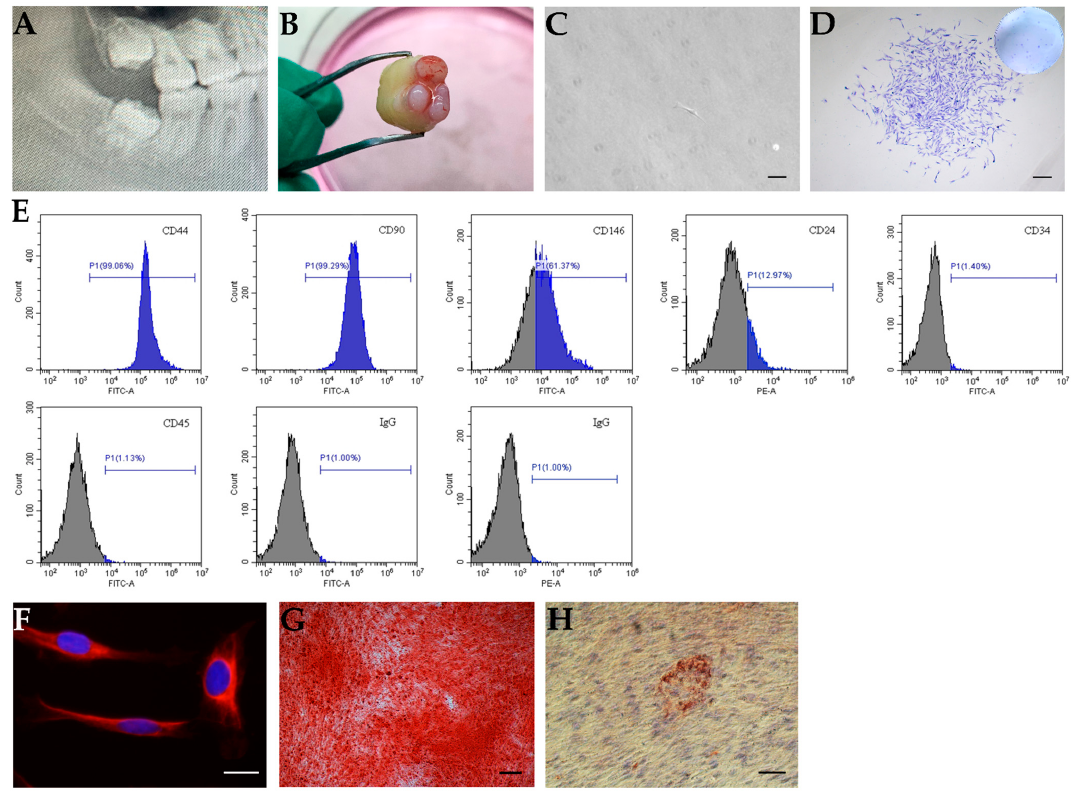
Figure 1. In vitro characterization of stem cells from apical papilla (SCAPs). ( A , B ) The apical papilla tissue from an immature human tooth. ( A ) A representative radiograph indicating the third molar with the open apex; ( B ) apical papilla tissue. ( C , D ) The colony formation of SCAPs. ( C ) SCAPs exhibited a typical spindle shape, scale bar = 100 µ m. ( D ) Isolated cells formed colony-like units, scale bar = 200 µ m. ( E ) Flow cytometric analysis of SCAPs using several markers. Cells were positive for CD44, CD90, CD146, and CD24, and negative for CD34 and CD45. ( F ) Immunofluorescence staining showed nestin expression in SCAPs, scale bar = 20 µ m. ( G ) SCAPs formed mineralized nodules after osteo-/odontogenic differentiation, scale bar = 200 µ m. ( H ) SCAPs were differentiated into adipocytes with Oil Red O-positive lipid clusters when cultured in adipogenic differentiation medium for four weeks, scale bar = 50 µ m.